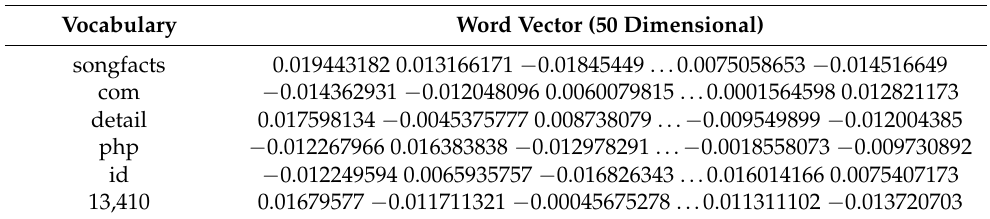
Table 3. Vocabulary example. The Vocabulary Example: